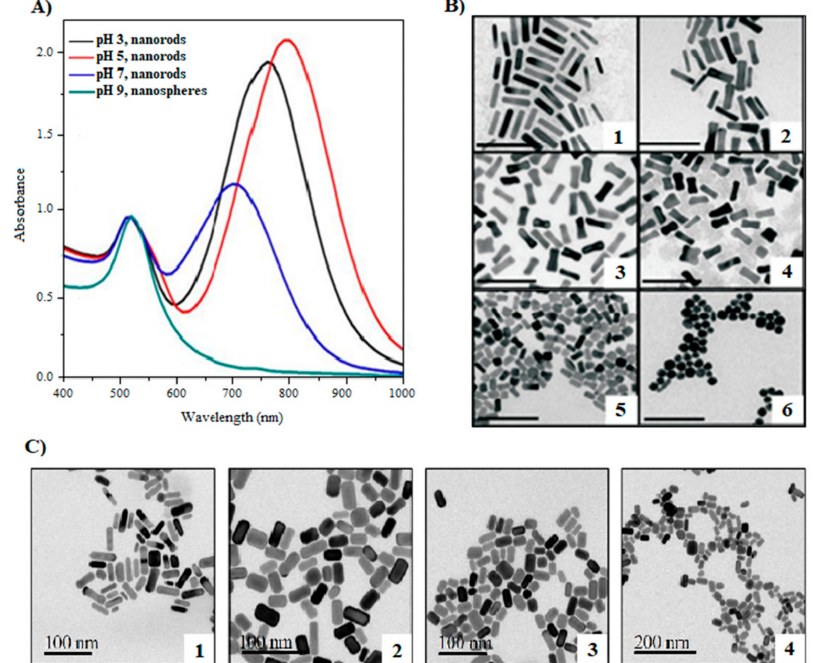
Figure 2. Effect of pH on the formation of Au NPs. ( A ) Absorption spectra of Au NPs synthesized using a 256 nm UV lamp and CTAB as the surfactant at different pH values for 1 h. Adapted from [107]. Published by IOP Publishing under Creative Commons Attribution 3.0 License. ( B ) TEM micrographs of Au NPs formed at different pH values: (1) 1.23, (2) 2.00, (3) 3.00, (4) 4.00, (5) 9.00, and (6) 10.28 (scale bar: 100 nm). Adapted from [108] with permission from Wiley. ( C ) TEM micrographs of Au NPs obtained using a UV lamp (256 nm) and CTAB at different HAuCl 4 concentrations: (1) 3.0 mM, (2) 4.5 mM, (3) 6.0 mM, and (4) 7.5 mM. Adapted from [110]. Published by The